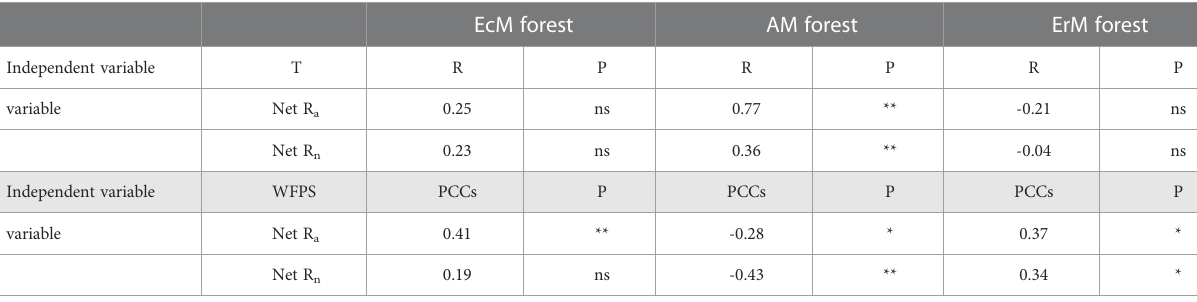
TABLE 2 Correlations between soil net ammoni fi cation rate (net R a ), soil net nitri fi cation rate (net R n ) and microclimate: soil temperature (T) and soil WFPS (water- fi lled pore space). EcM forest AM forest ErM forest Independent variable T variable